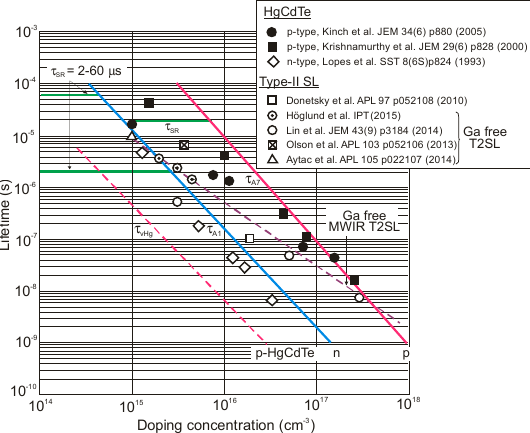
Figure 29. Hole minority carrier lifetime versus inverse temperature for a n-type MWIR InAs/InAs 0.54 Sb 0.46 T2SL with doping concentration 5 × 10 14 cm − 3 (after [114]).